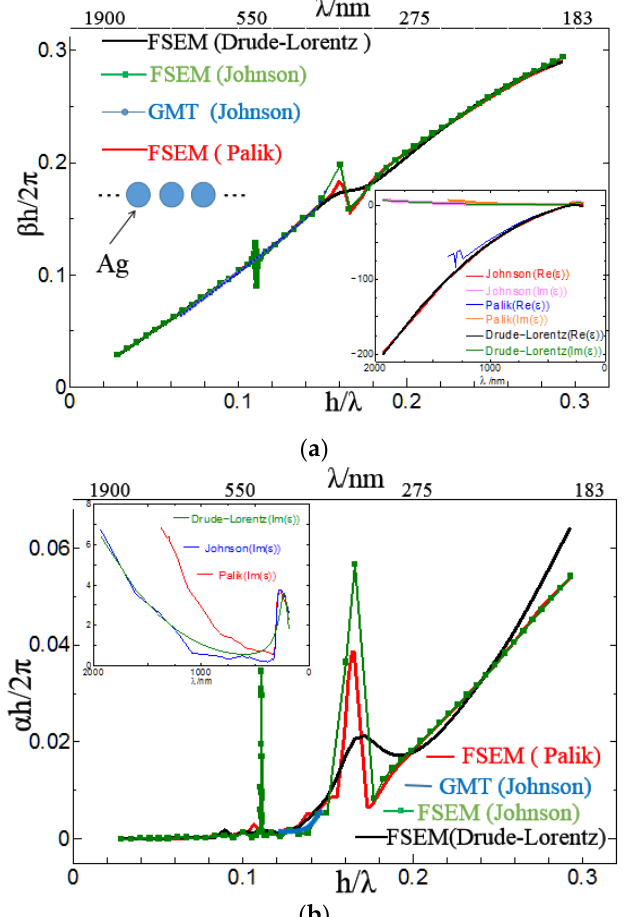
Figure 3. Phase constant and attenuation constant of infinite long silver nanorod arrays with r = 25 nm and h = 55 nm corresponding to the four results. The inset shows the dielectric function, as reported in [34–38]. ( a ) Phase constant; ( b ) attenuation constant.